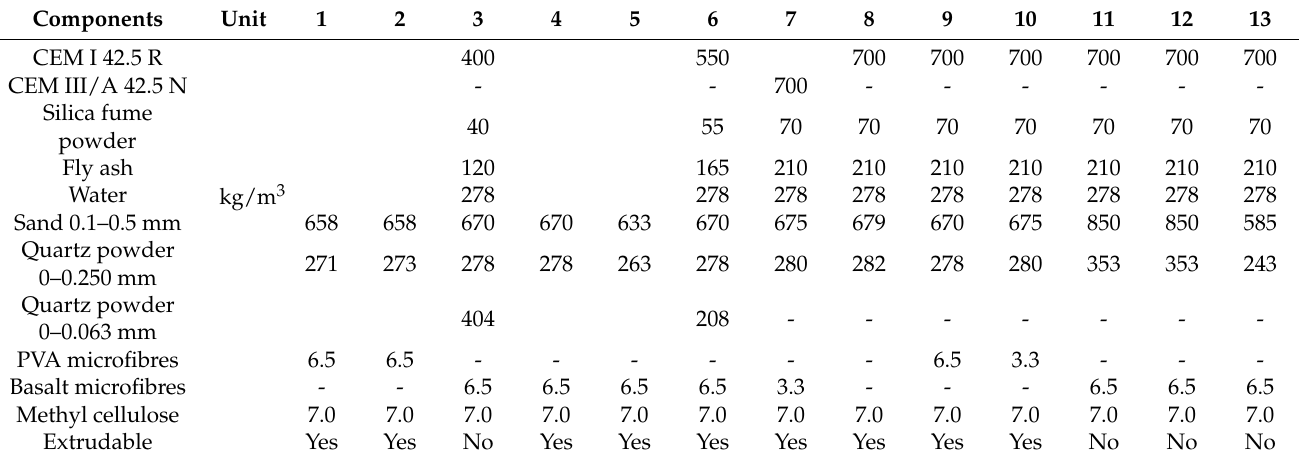
Table 1. Mix design of the investigated